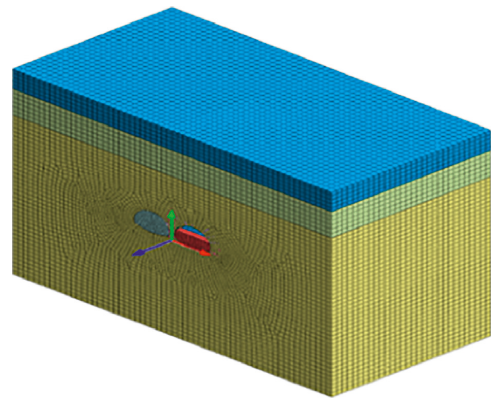
Figure 7: Tunnel model